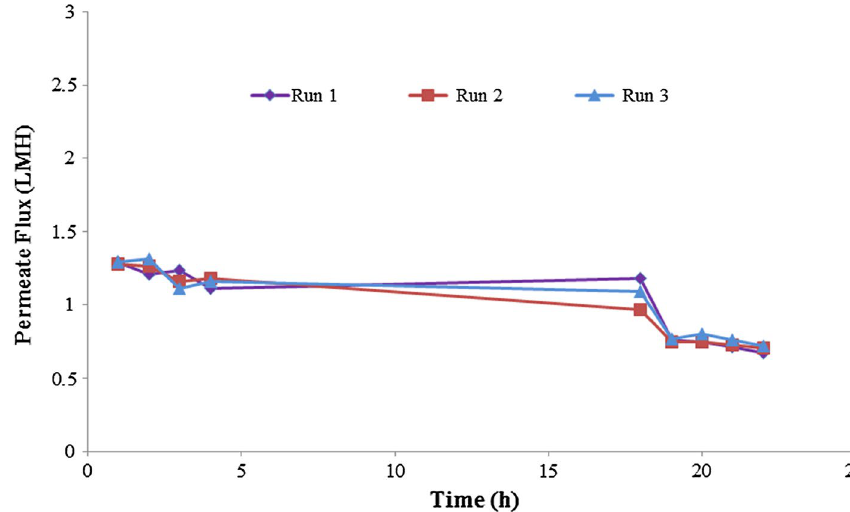
Fig. 6 Permeate flux as a function of time (